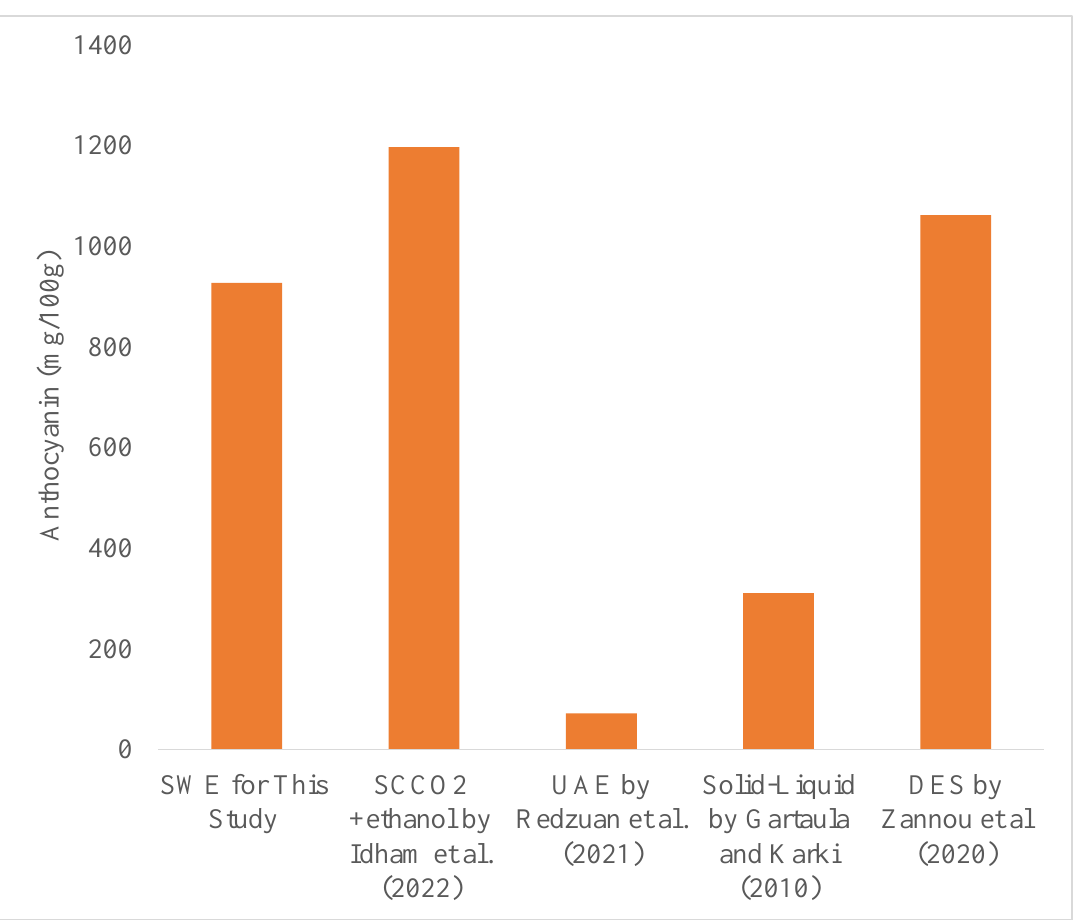
Figure 7. Comparison of the anthocyanin recovery between this study and previous studies [6,36 – 38].